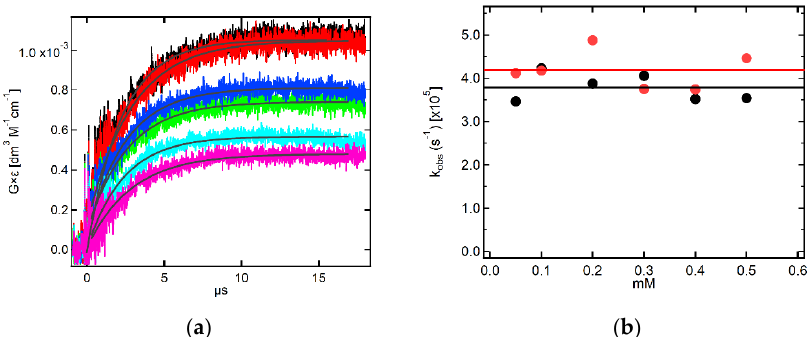
Figure 7. ( a ) Time profiles representing growth of transient absorptions at λ = 430 nm recorded after the electron pulse in N 2 O ‐ saturated aqueous solutions at pH = 7 containing 0.1 M NaN 3 and various concentrations of 7 ‐ OCH 3 ‐ 3 ‐ MeQ: ( ▬ ) 0.05 mM, ( ▬ ) 0.1 mM, ( ▬ ) 0.2 mM, ( ▬ ) 0.3 mM, ( ▬ ) 0.4 mM and ( ▬ ) 0.5 mM; ( b ) Plots of the observed pseudo ‐ first ‐ order rate constants of the formation of the 430 ‐ nm absorption ( ● ) and the 530 ‐ nm absorption ( ● ) as a function of 7 ‐ OCH 3 ‐ 3 ‐ MeQ concentration in N 2 O ‐ saturated aqueous solutions at pH = 7 containing 0.1 M NaN 3 . The pseudo ‐ first ‐ order rate constants of the formation of the 430 ‐ nm and 530 ‐ nm ab ‐ sorption bands were plotted as a function of 7 ‐ OCH 3 ‐ 3 ‐ MeQ concentration (Figure 7b).